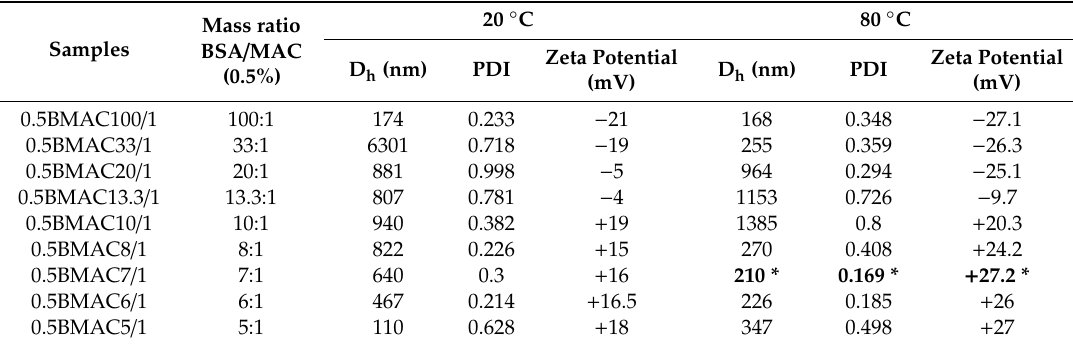
Table 2. Characteristics of BSA and MAC nanogels obtained by diffraction light scattering (DLS) measurements.